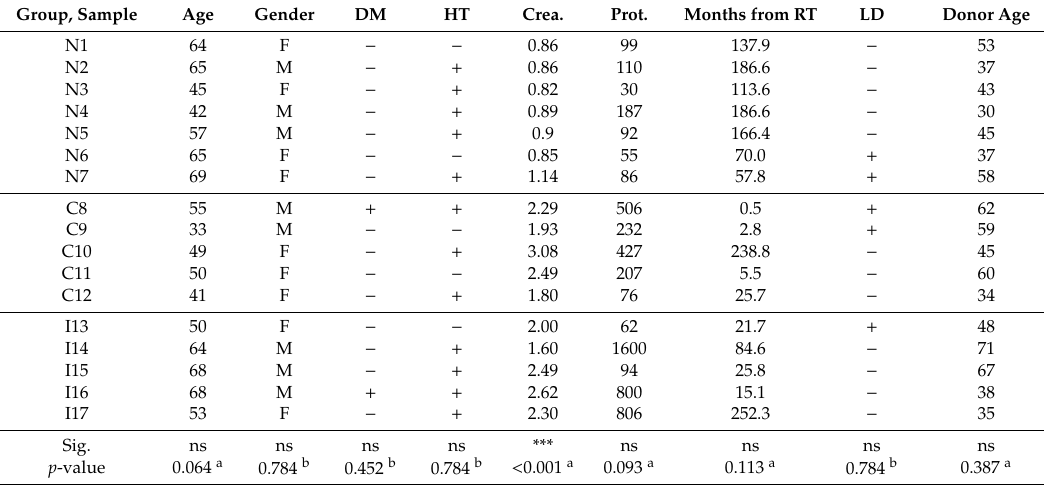
Table 1. Clinical parameters of the study patients at urine collection.